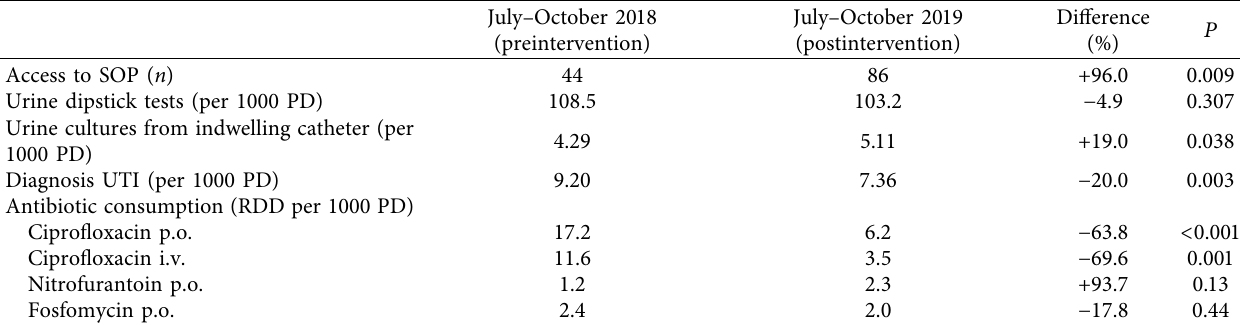
Table 1: Differences in evaluated indicators pre and postinterventions.